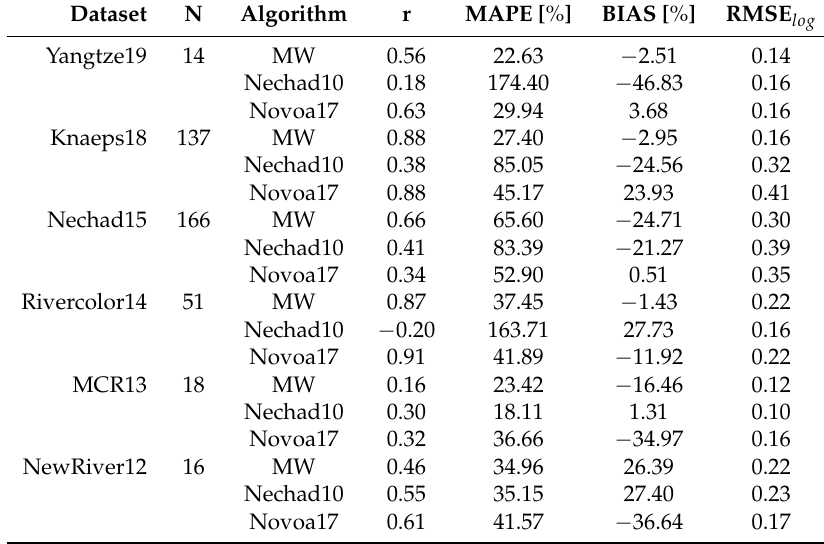
Table 6. Metrics of performance for the different Suspended Particulate Matter (SPM) algorithms of field data by dataset.